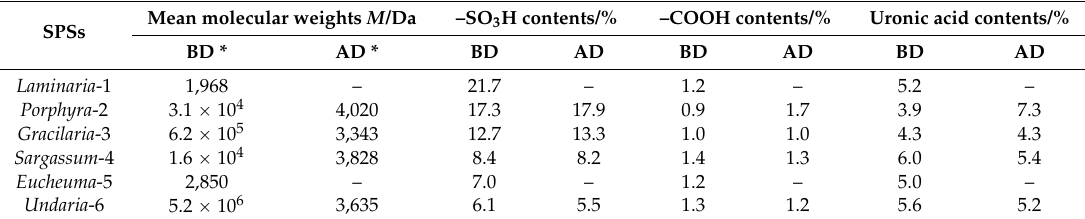
Table 2. Molecular weight, –SO 3 H content, and –COOH content of native and degraded SPSs. Mean molecular weights M /Da –SO 3 H contents/% –COOH SPSs